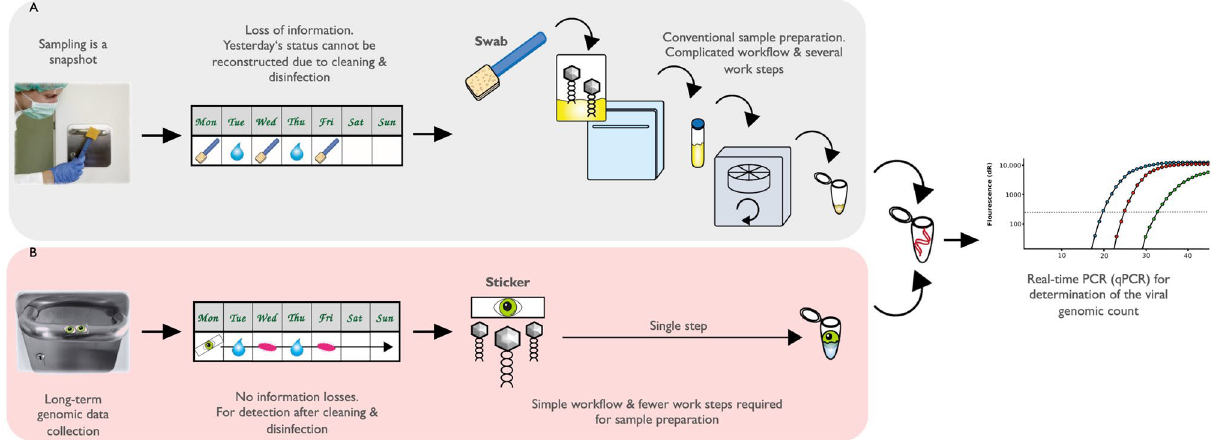
Figure 1. This figure depicts surface sampling procedures using common swabs ( A ) and paper-based adhesive stickers ( B ). While conventional swabbing before and after each hygiene step is required for reliable results long- term, the sticker approach requires only one self-adhesive sticker, which can be easily applied to a wide variety of surfaces. The sticker approach ( B ) also provides a simple workflow and fewer steps than conventional swab sampling ( A ) prior to qPCR